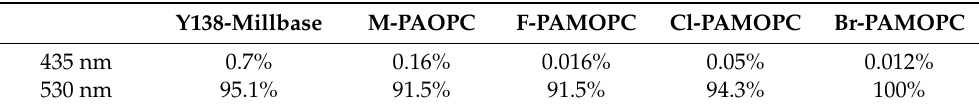
Figure 1. The transmittance spectra of the synthesized materials at a concentration of 1 × 10 − 4 M in PGMEA. Table 2. The transmittance values of the synthesized yellow materials at 435 and 530 nm.